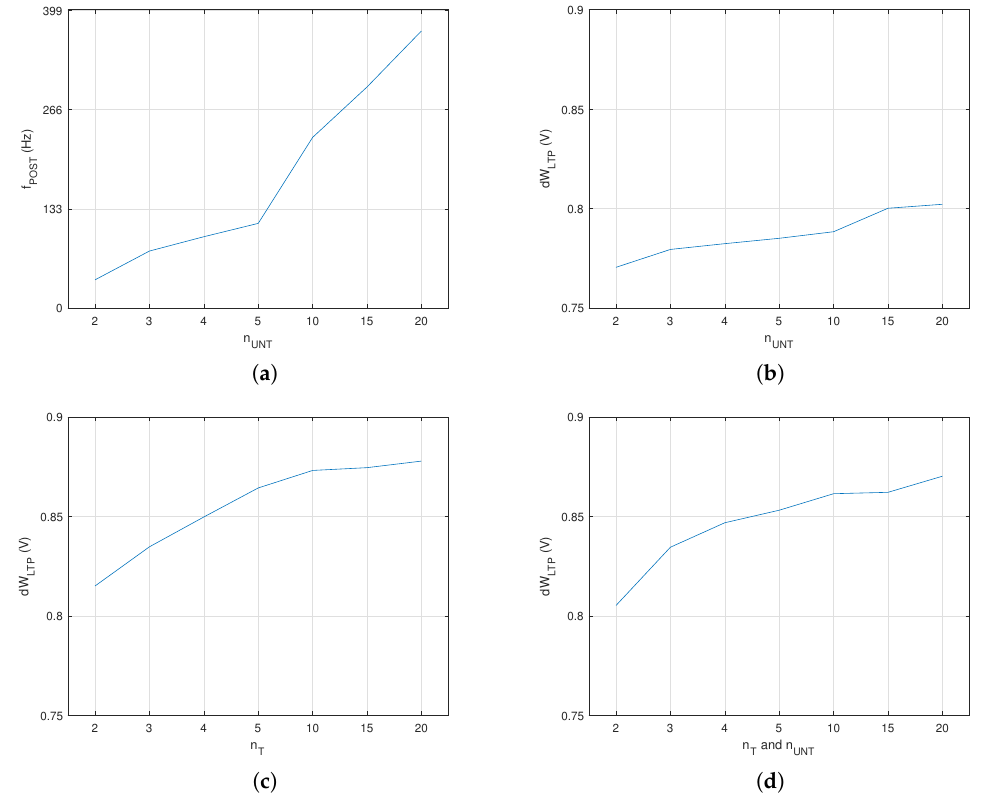
Figure 4. ( a ) The frequency of the output neuron. The synaptic weight variation by LTP after 2 s of training for variation in the number of ( b ) untrained neurons with f UNT = 75 Hz; ( c ) trained neurons with f T = 100 Hz; ( d ) both trained and untrained